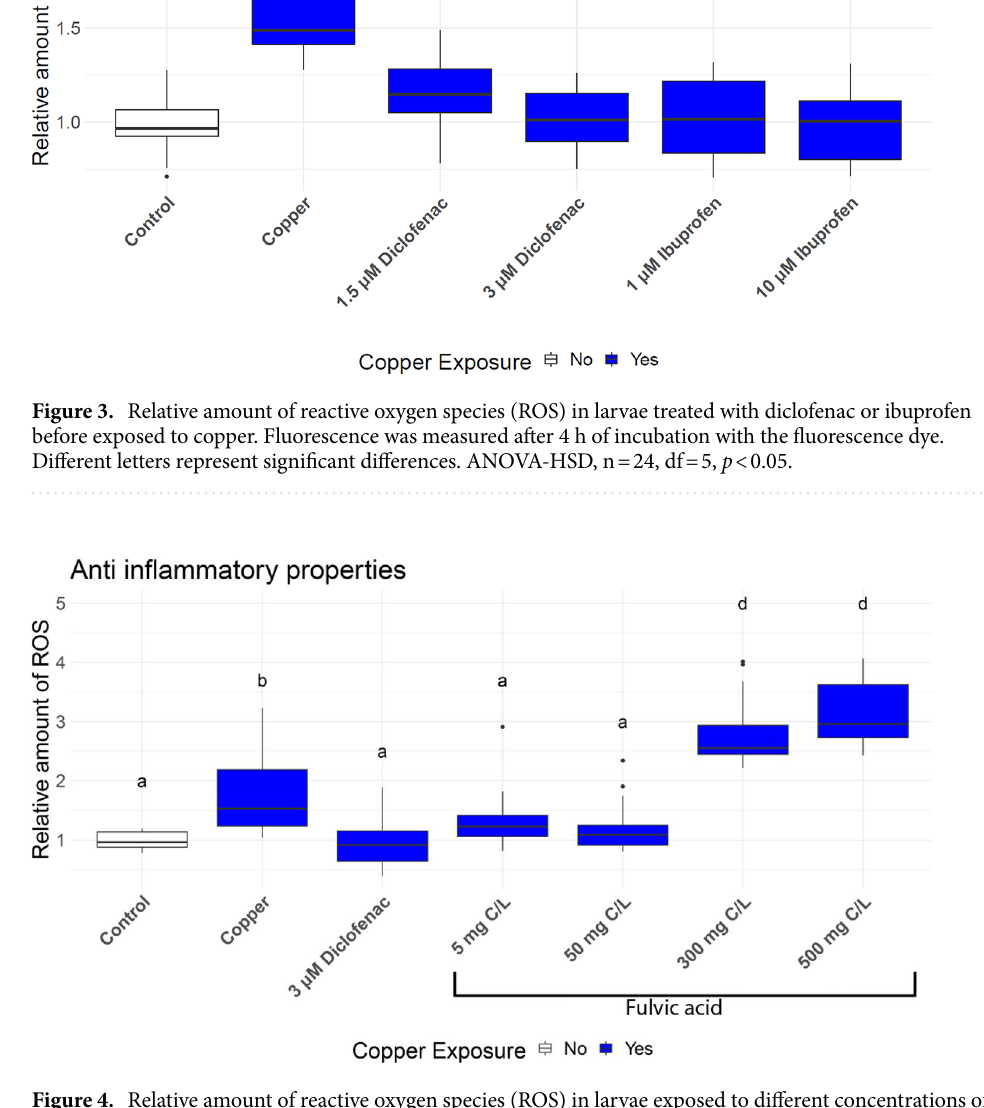
Figure 4. Relative amount of reactive oxygen species (ROS) in larvae exposed to different concentrations of fulvic acid for 96 h and copper for 2 h. Diclofenac larvae were exposed only to diclofenac for 1 h before being exposed to copper. Fluorescence was measured after 4 h of incubation with the fluorescence dye. Different letters represent significant differences. ANOVA-HSD, n = 24, df = 5, p <